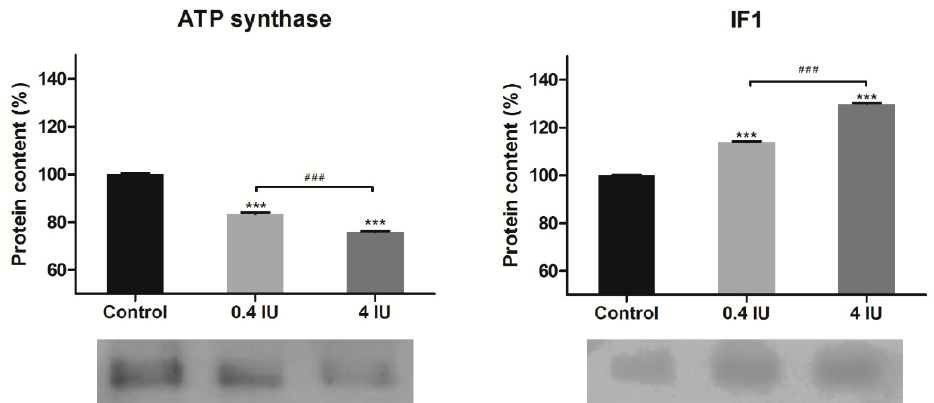
Figure 6. Effects of chronic insulin treatment on the expression of ATP synthase and IF1 in MEF. Protein content is expressed relative to controls, which were standardized to 100%. Mean ± SEM values are averages of three independent experiments performed in triplicate (pooled from six animals in each group). A representative blot is shown. Volume is the sum of all pixel intensities within a band (1 pixel = 0.007744 mm 2 ). * compared to control: *** p ≤ 0.001; # 0.4 IU vs. 4 IU: ### p ≤ 0.001.